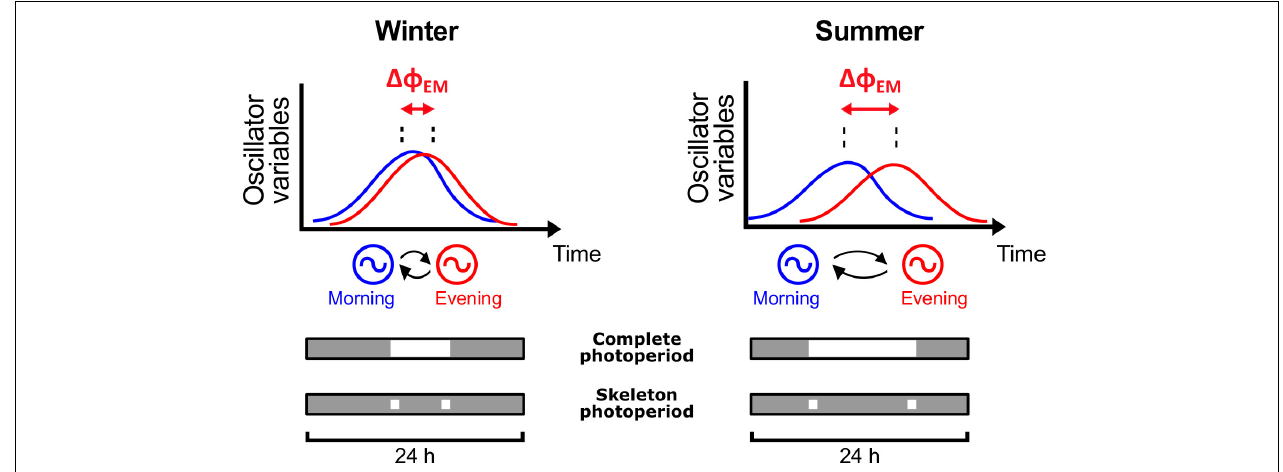
FIGURE 5 | Schematic representation of the two-oscillator model of the circadian clock and its role in photoperiod encoding. The model proposed by Pittendrigh and Daan (1976c) consists of a morning (M) oscillator that tracks dawn and an evening (E) oscillator that tracks dusk. M and E (circles) are coupled to each other (curved arrows). In the upper graphs, blue and red curves represent the state variables of M and E, respectively. As the photoperiod changes from short days in winter to long days in summer, there is a change in the phase relationship between E and M ( (cid:49)(cid:56) EM , red horizontal arrows), which modifies the state of the circadian clock. Below the graphs, gray/white bars represent the light/dark times of the LD cycles. Upper bars indicate an LD cycle with complete photoperiod, i.e., light occurring during the complete photophase. Lower bars represent skeleton photoperiods, a simplified experimental protocol that reproduces the effects of photoperiod with only two light pulses, applied at the